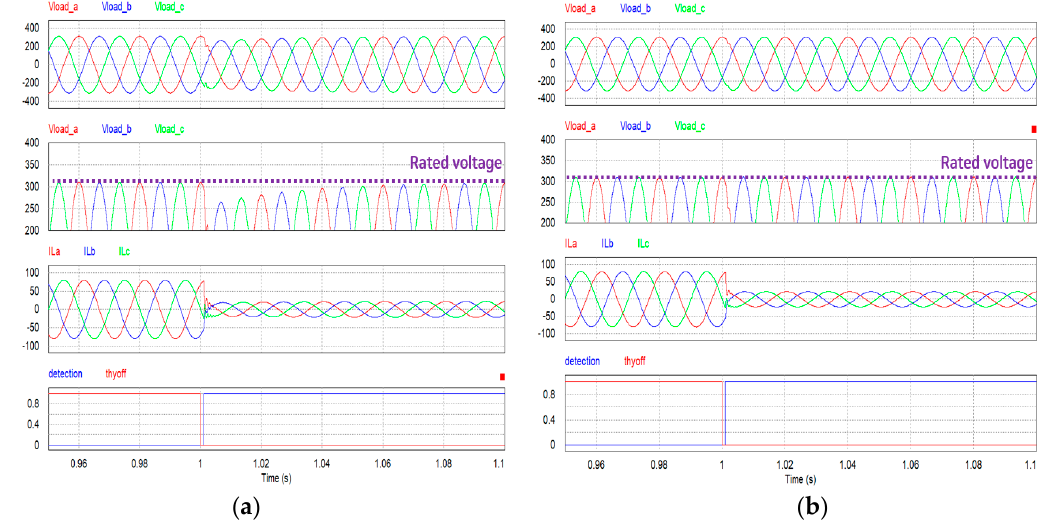
Figure 11. Simulation results of mode switching in the case of a grid fault during renewable energy generation: ( a ) using the general inverter controller; ( b ) using the proposed load current compensation controller.